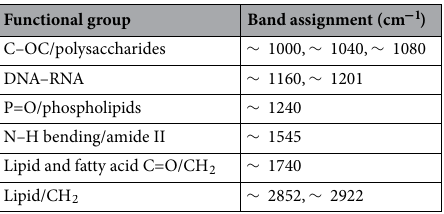
Table 1. Infrared absorbance peak assignment for Thalassiosira weissflogii .